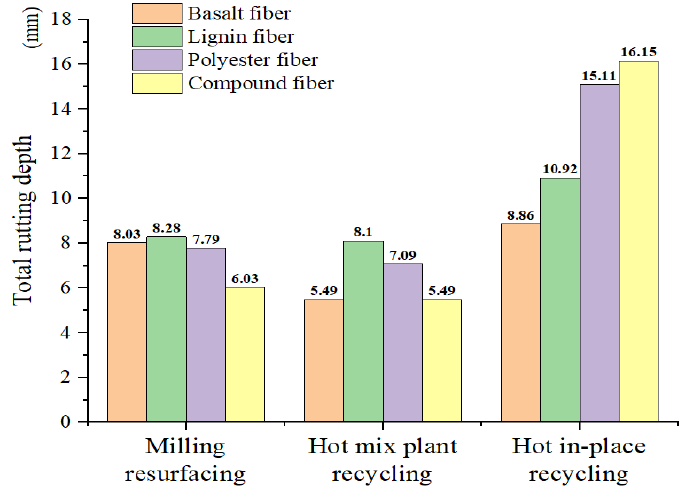
Figure 15. Total rutting depth at the end of HWTT.